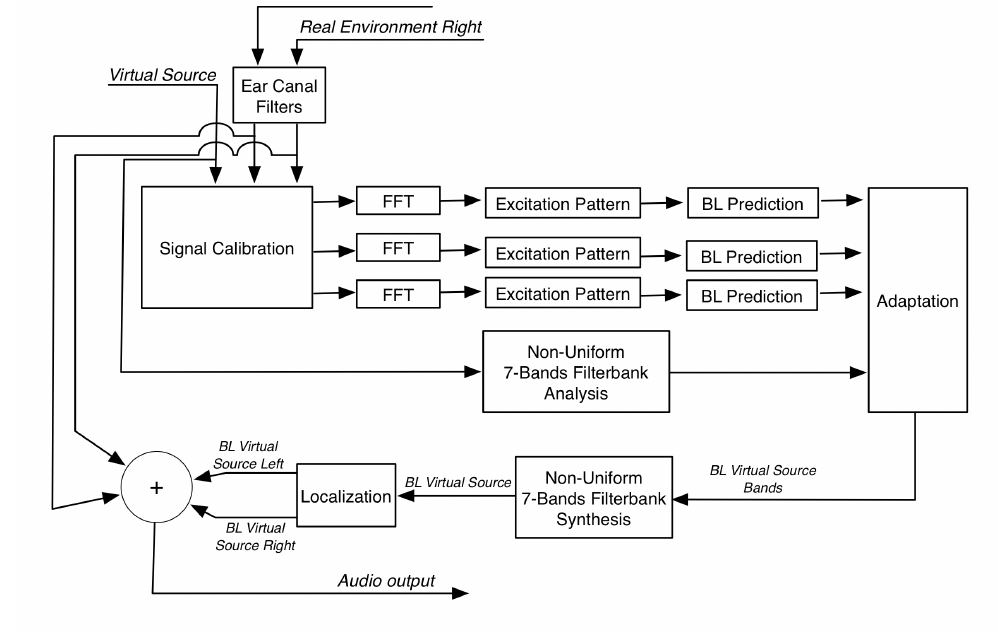
Figure 3. Technical overview of the adaptive ARA mix